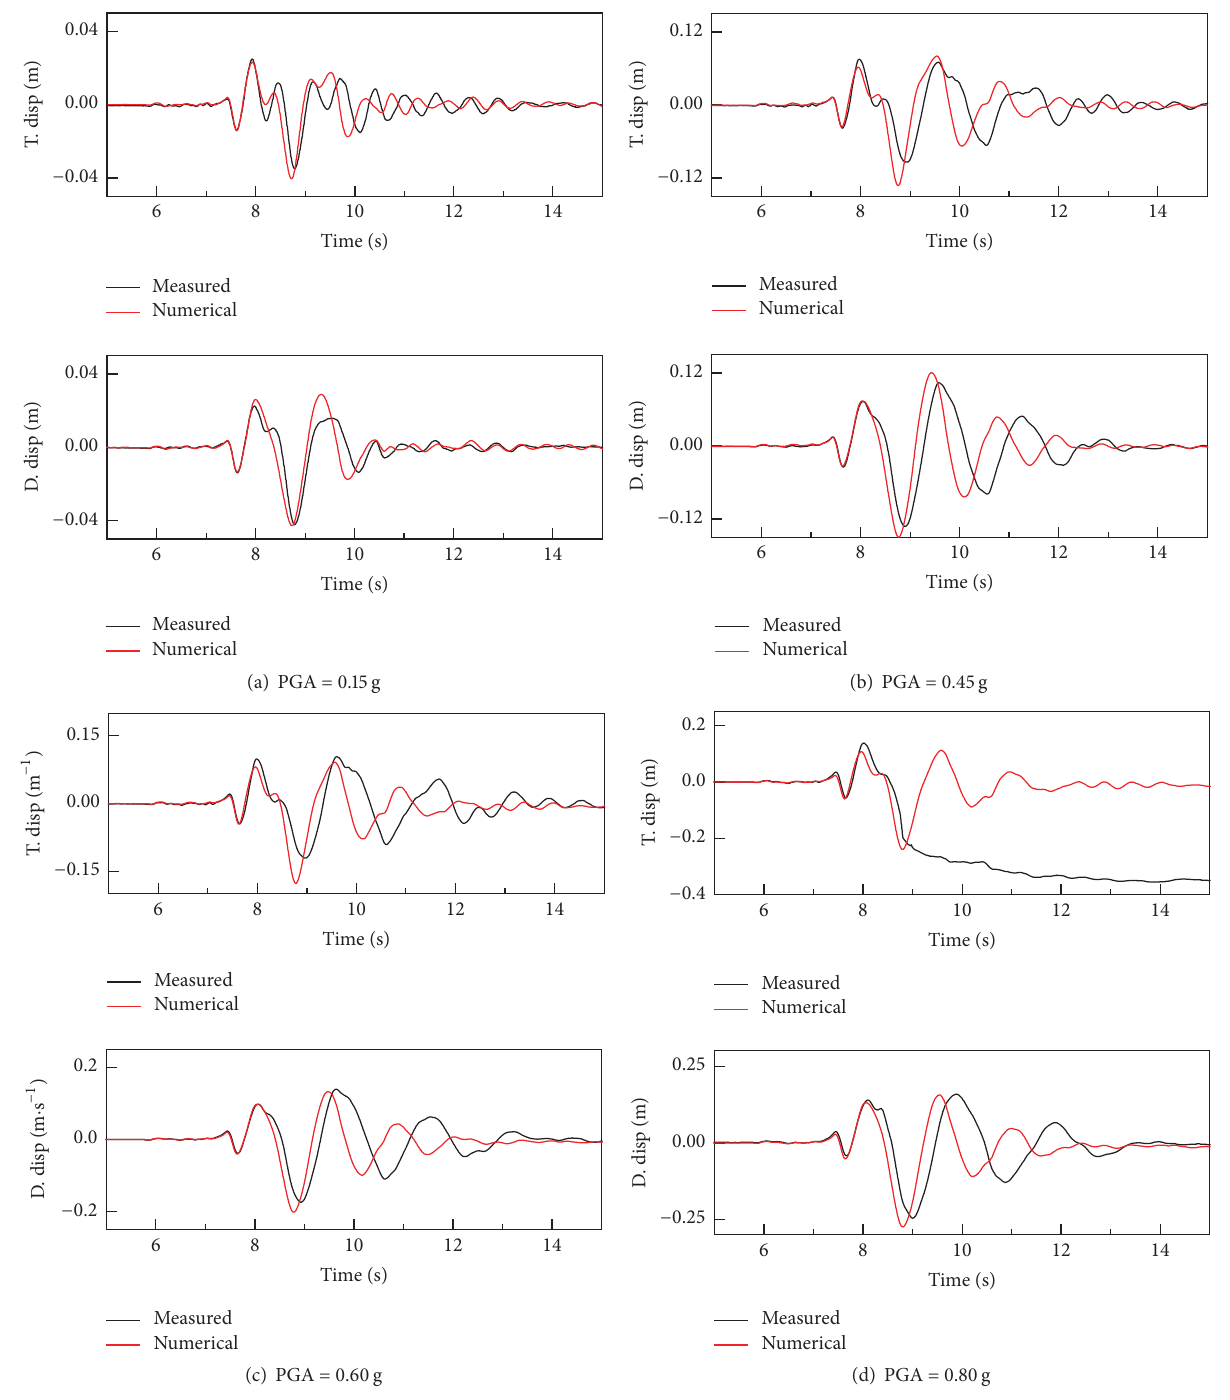
Figure 14: Comparisons between measured and numerical results of displacement histories at tower top and deck